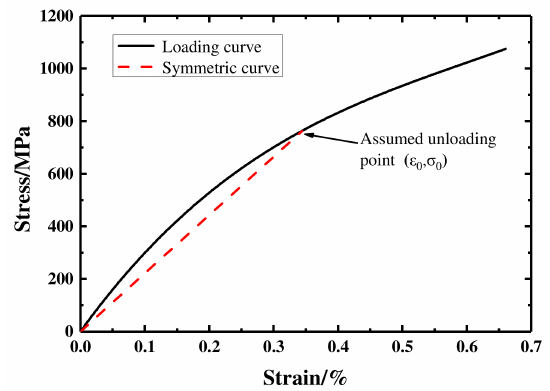
Figure 10. Loading curve and assumed unloading